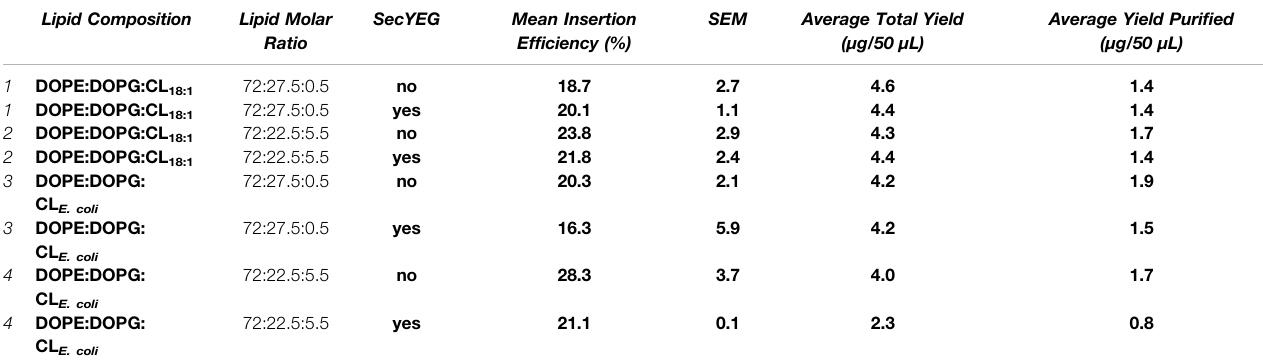
SecYEG was reconstituted into liposomes at both 1 in 25 and 1 in 100 (w/w) protein: lipid ratios. In both lipid mixes where SecYEG was reconstituted at 1 in 25 (w/w) protein: lipid ratio, there was an increase in LeuT insertion ( Table 4 ). In 72:27.5:0.5 mol ratios of DOPE:DOPG:CL 18:1 , we see a spontaneous insertion of 23.6 ± 1.7% for 1 in 25 SecYEG conditions, compared to 20.1 ± 1.1% and 21.8 ± 0.8% for 1 in 50 and 1 in 100 conditions respectively ( p < 0.17 – 0.31). In 72:22.5: 5.5 DOPE:DOPG:CL 18:1 , we see a similar, yet more pronounced effect where spontaneous insertion is found to be at 32.3 ± 0.1% for 1 in 25 SecYEG, compared to 21.8 ± 2.4% and 22.8 ± 0.5% for 1 in 50 and 1 in 100 conditions respectively ( Table 4 ). The increase in insertion for 1 in 25 SecYEG in this lipid condition is statistically signi fi cant ( p < 0.040) when compared with empty liposomes of the same composition ( Figure 3 ). In addition to the mean insertion rates, the yield of protein produced remains consistent across all SecYEG reconstitutions and are ™ IVTT yields. comparable to other EXPRESSway